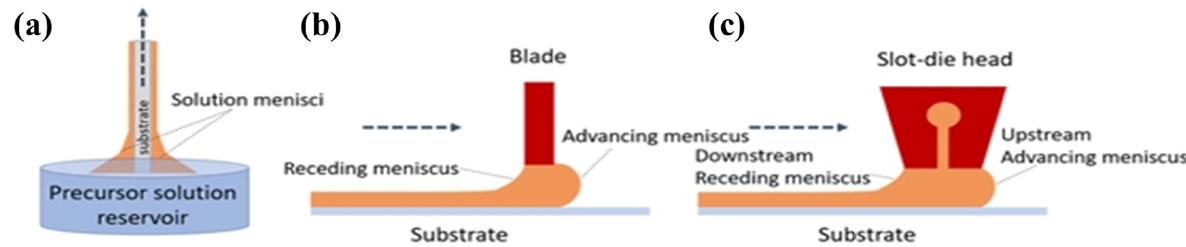
Figure 13. Schematic processes for film coating: ( a ) dip coating; ( b ) blade coating, and ( c ) slot-die coating. Reprinted from ref. [38].